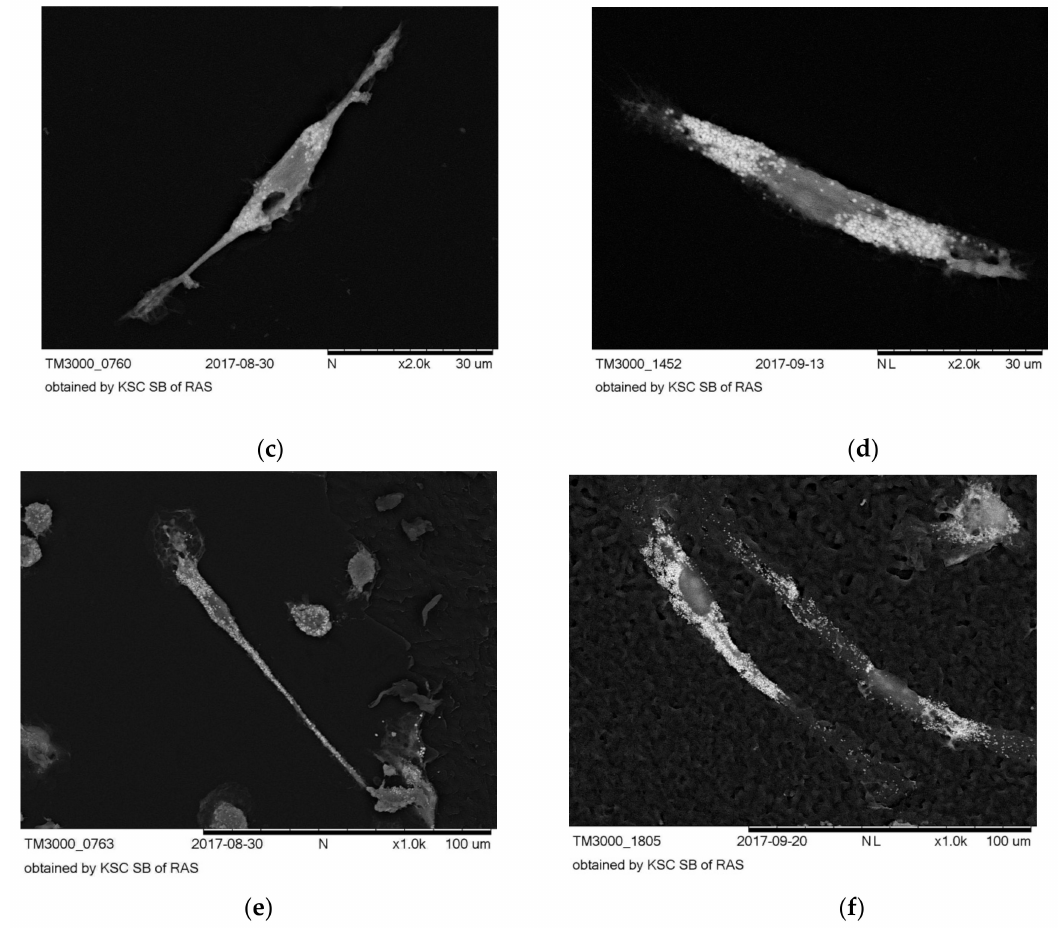
Figure 3. The main morphological classes (MC) of MPhs. Cultivation for six days in vitro. ( a , b )—rounded cells, MC1; ( a )—morphotype of multinucleated cells, ( b )—morphotype